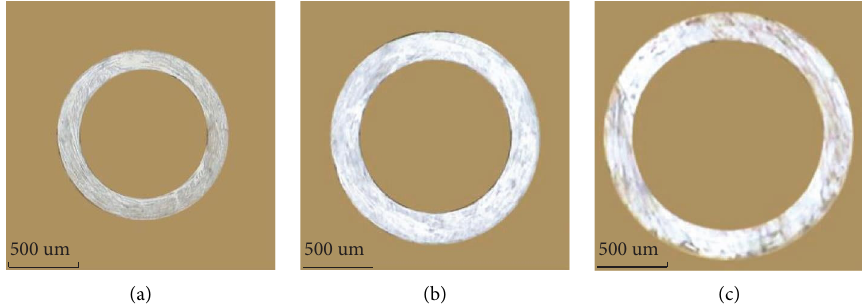
Figure 8: Cross-sections of the target microtubes: (a) (1.0, 0.15), (b) (1.0, 0.20), and (c) (1.5, 0.20).